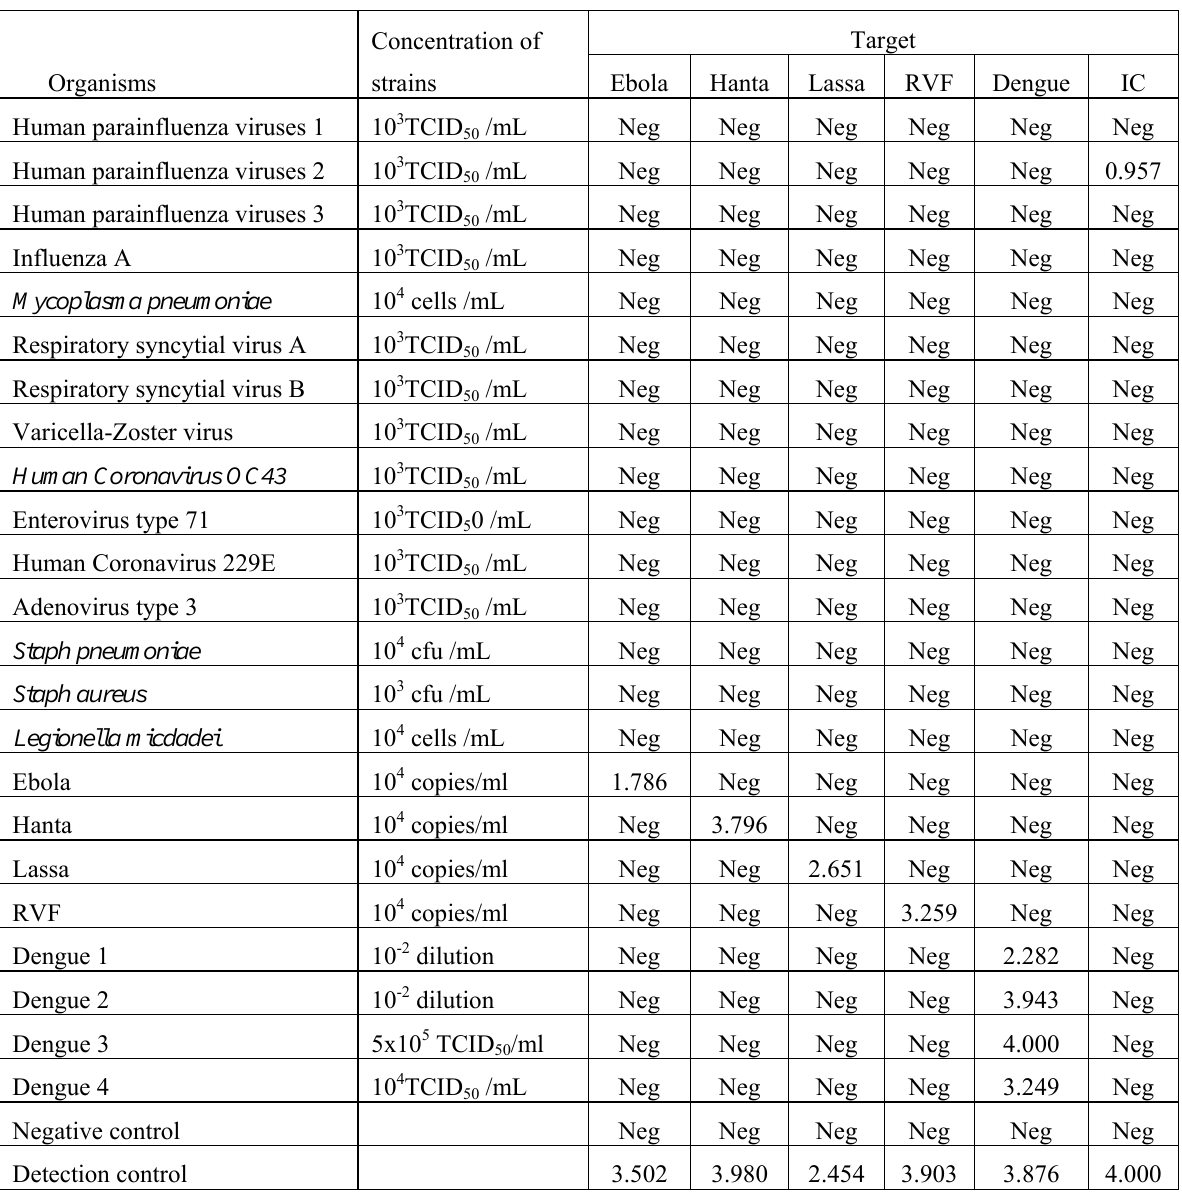
B. The organism, dilution and the result of the specificity testing for BioT RNA multiplex